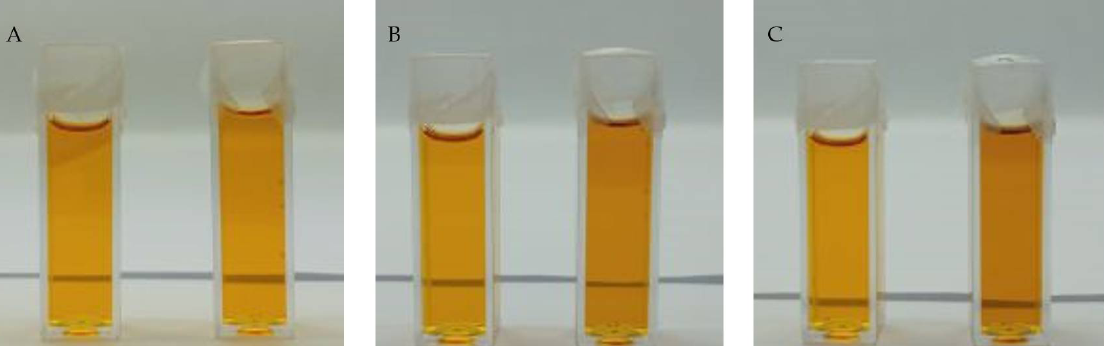
Figure 5. Photographs of the Fricke-XO-Pluronic F-127 dosimeter samples without and with 0.2 M NaCl, which were stored at about 4 °C in a refrigerator and protected from light: ( A )—immediately after preparation, ( B )—24 h, ( C )—48 h. The samples on the right-hand side contain NaCl. The Fricke-XO-Pluronic F-127 without and with 0.2 M NaCl was analyzed by using UV-Vis spectrophotometry over the time of storage under different conditions as reported